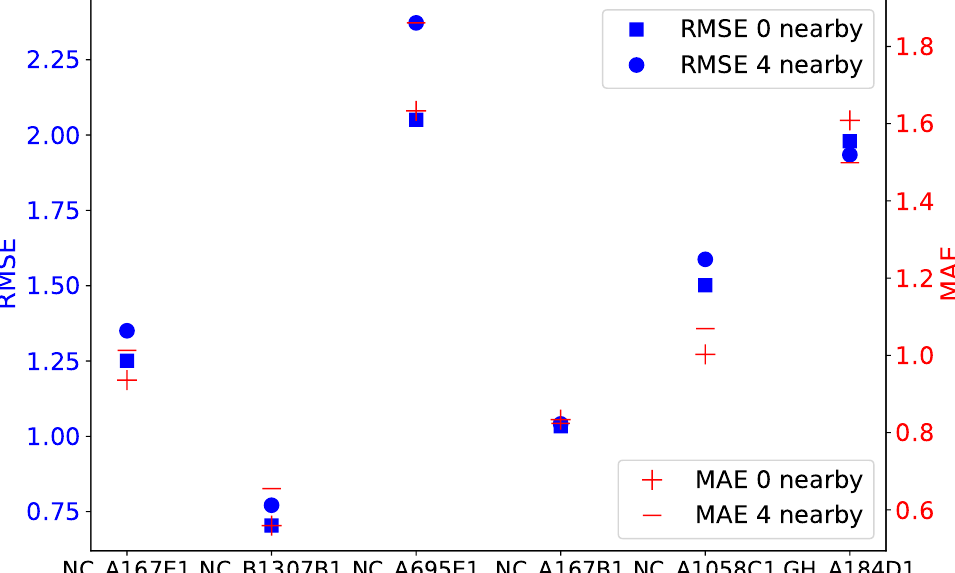
Figure 10. MAE and RMSE values calculated per CCTV sensor for RF prediction results shown in Figure 9. Values in blue and red correspond to RMSE and MAE,